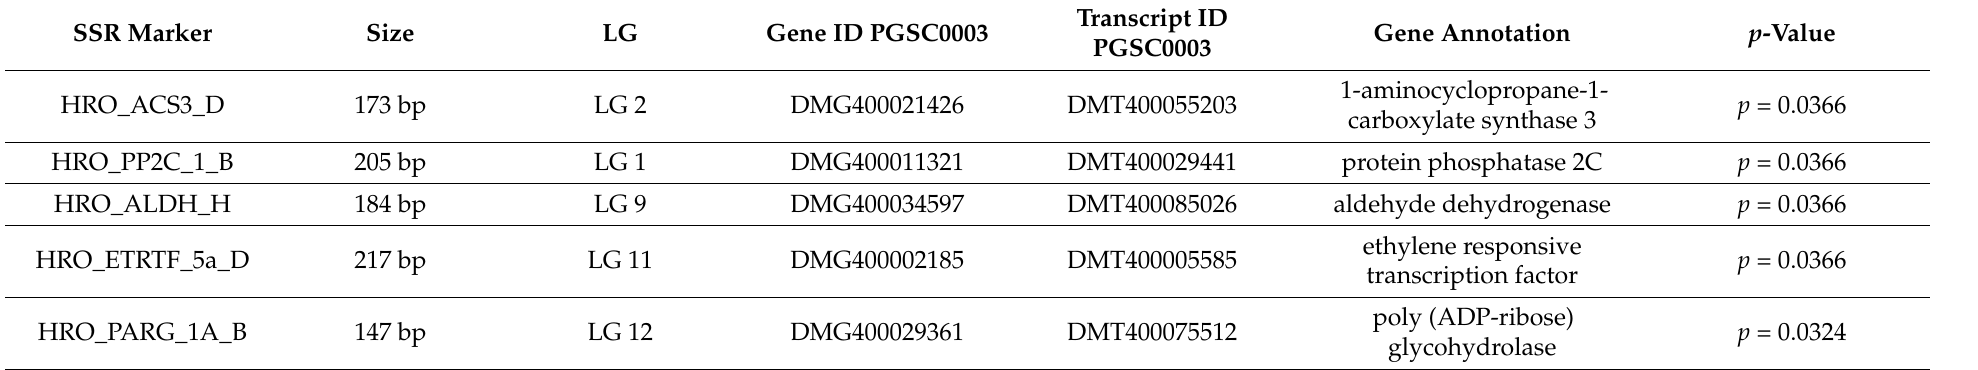
Table 2. SSR Markers significantly associated with drought tolerance in